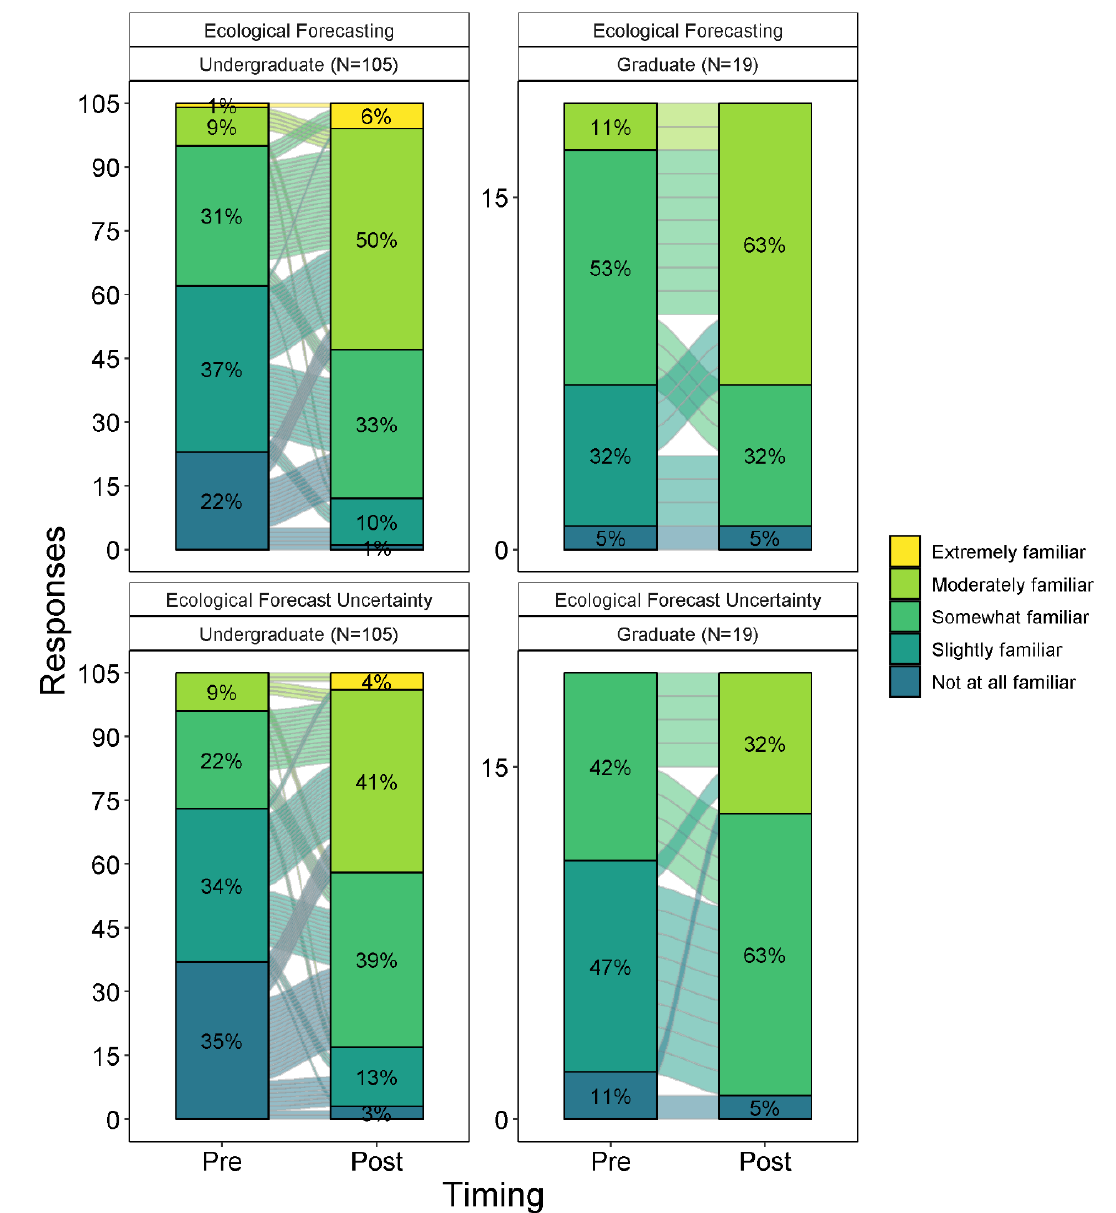
Figure 6. Students’ self-reported familiarity with ecological forecasting (left column) and ecological forecast uncertainty (right column) for undergraduate (n = 105, top row) and graduate (n = 19, bottom row) students in the pre- and post-assessment. Lines between bars represent changes in individual responses pre- and post-module use. Statistical results are given in Table A10.